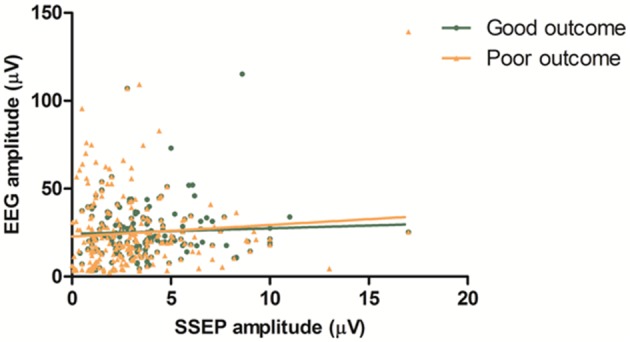
EEG vs. SSEP amplitude. Mean amplitudes of left and right hemisphere are combined in this figure. There is no statistically significant correlation between SSEP amplitude and EEG amplitude (R2 < 0.01). There is no statistically significant difference of SSEP/EEG amplitude ratio between patients with good and poor outcome (P = 0.64).